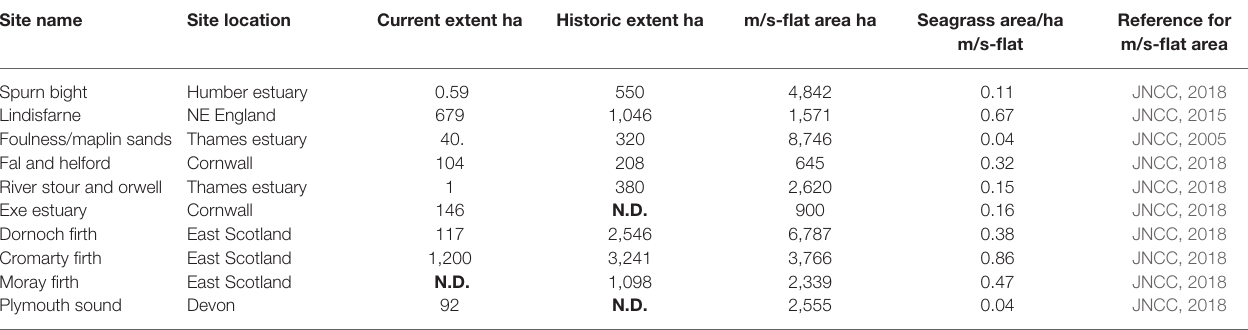
TABLE 1 | Seagrass meadow area data used to calculate historic seagrass loss in the United Kingdom. Site